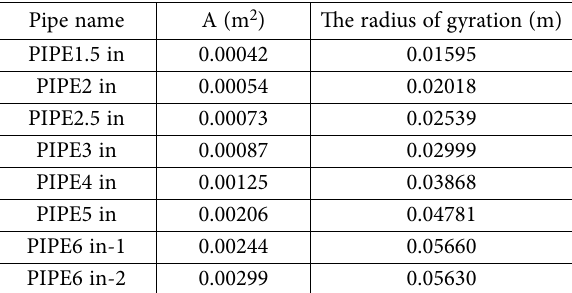
Table 8. List of members in 1152-bar example